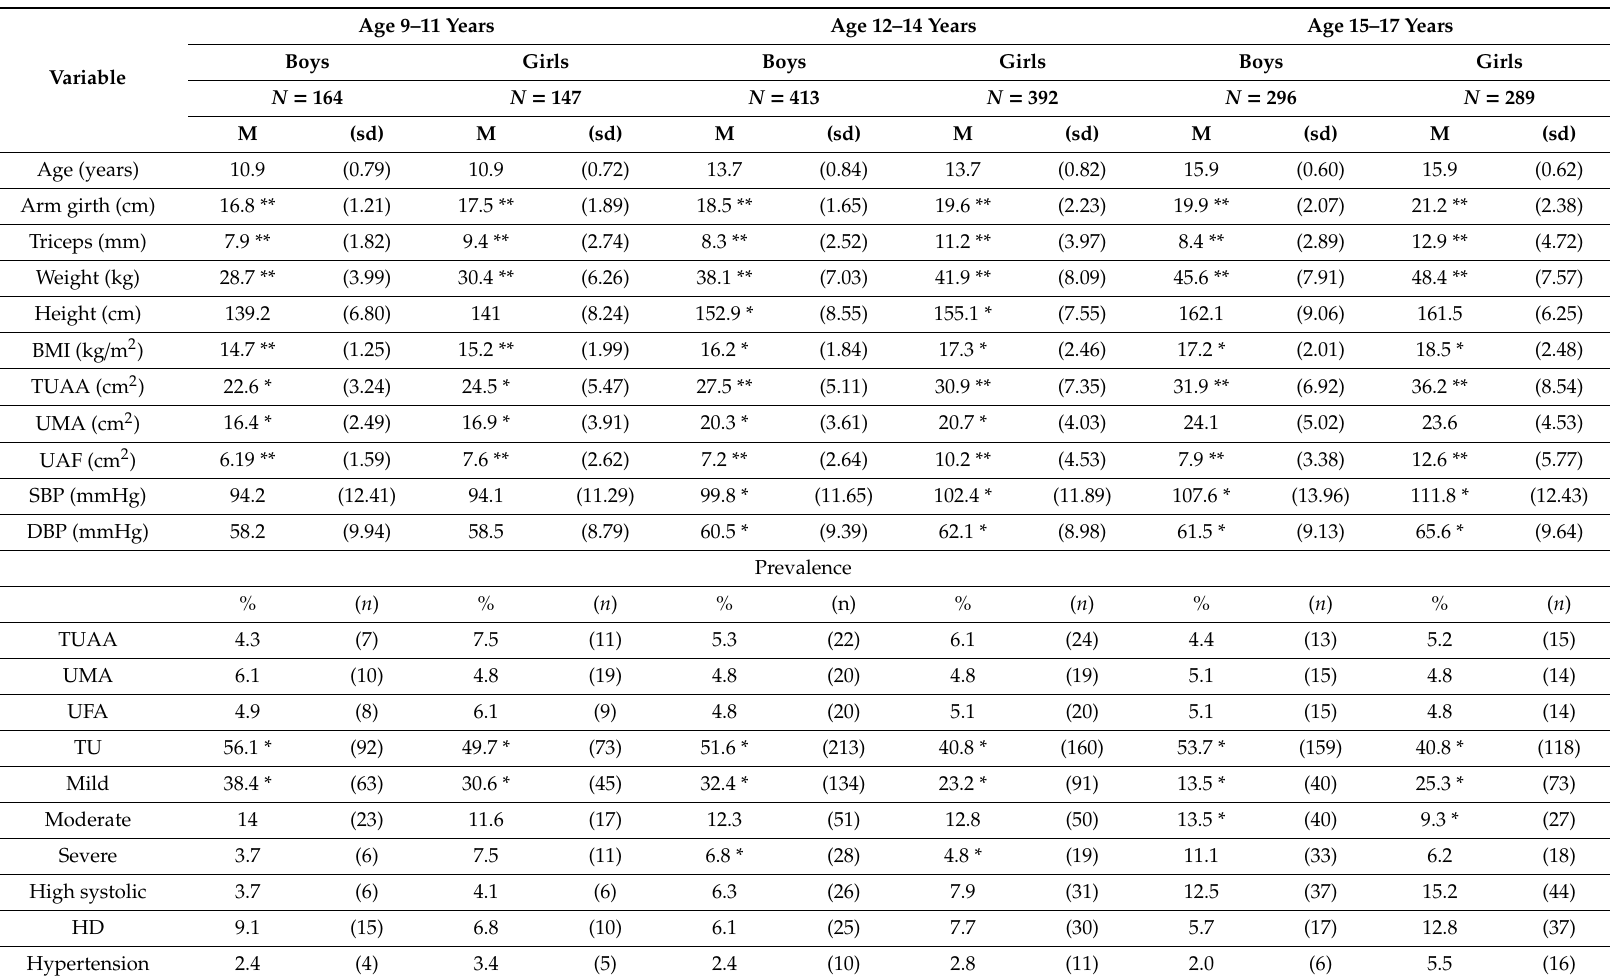
Table 1. Descriptive statistics for under-nutrition variables and blood pressure for Ellisras rural children age 9–17